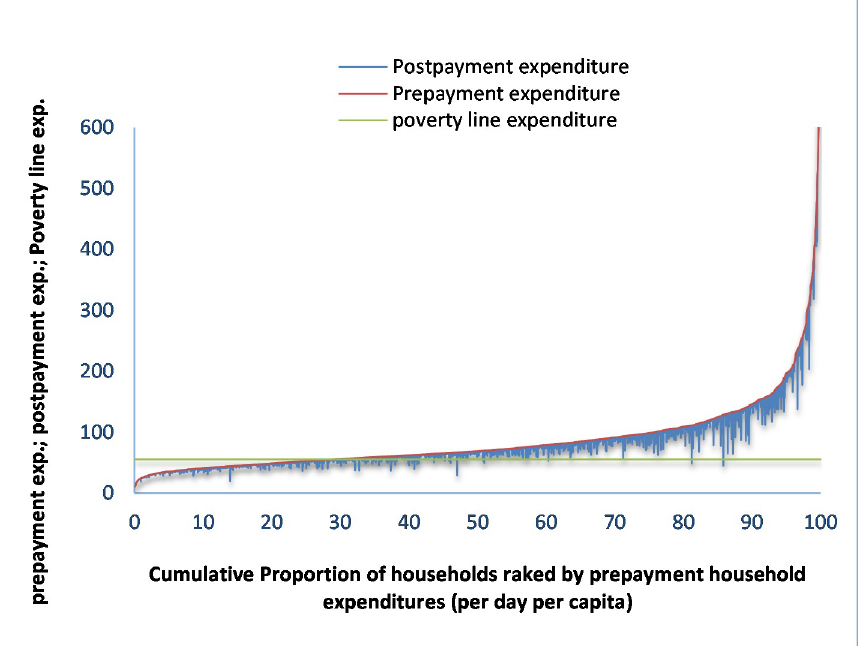
Fig 3. Poverty Pen’s parade graph for all ailments in LDP